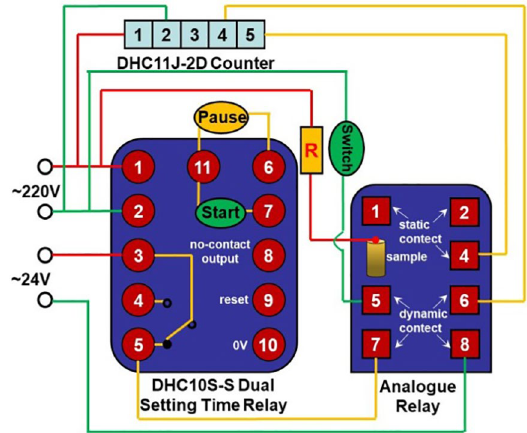
Figure 2. Circuit diagram of the electrical life simulation test system of the contact materials.